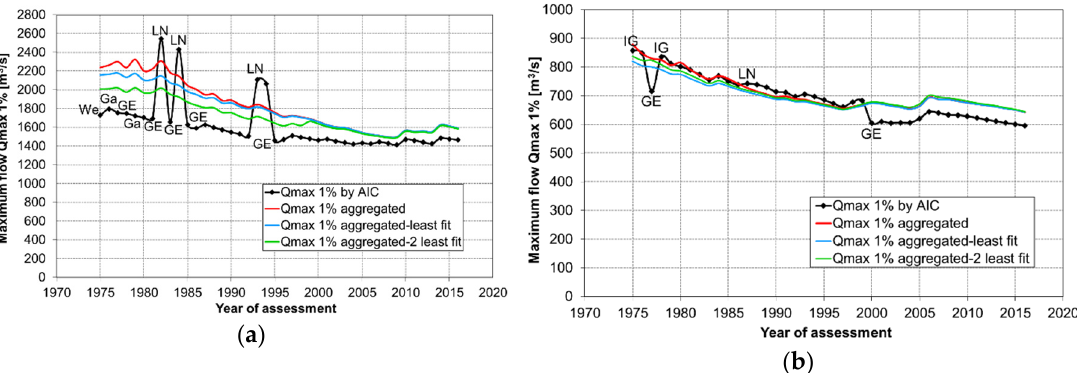
Figure 6. The estimates of the 1% quantile of ( a ) summer and ( b ) winter peak flows for the Proszówki gauging station on the Raba River obtained by the method of selecting the best fit distribution and by the aggregation method with variants of the candidate distributions.